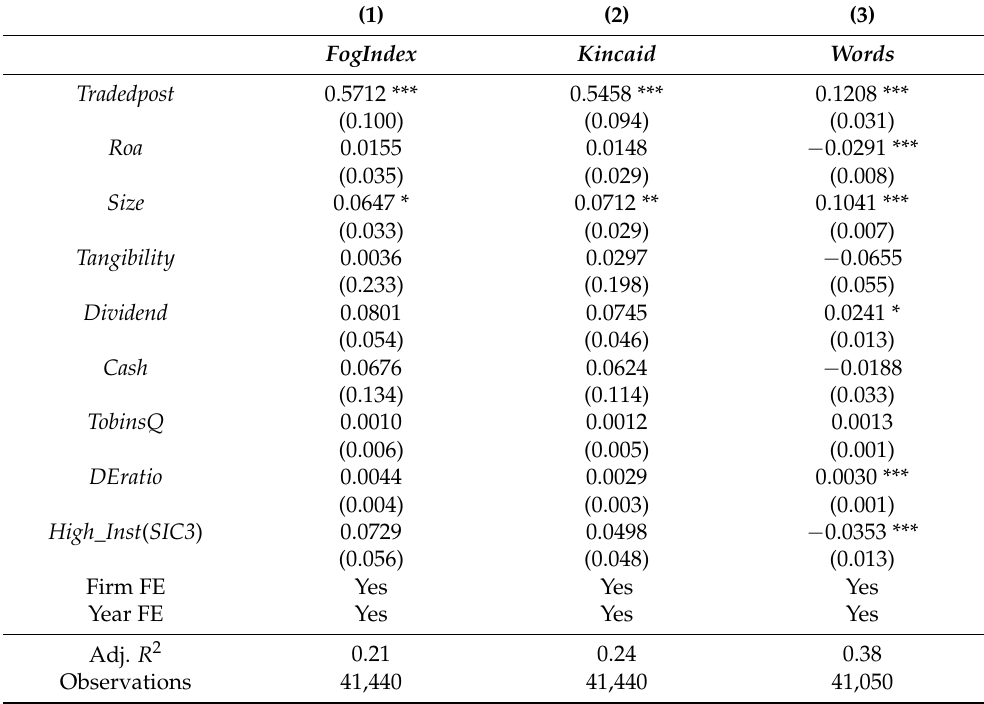
Table 6. CDS initiation and 10-K readability. This table reports the results of regression model (3) using our three main readability measures for a firm’s 10-K filings. Standard errors were clustered by firms and reported in parentheses. Lagged firm-specific controls and firm and year fixed effects are included in all specifications. Coefficients with *, **, or *** indicate a significance level of 0.10, 0.05, or 0.01, respectively. For detailed definitions of variables, please refer to Appendix A Table